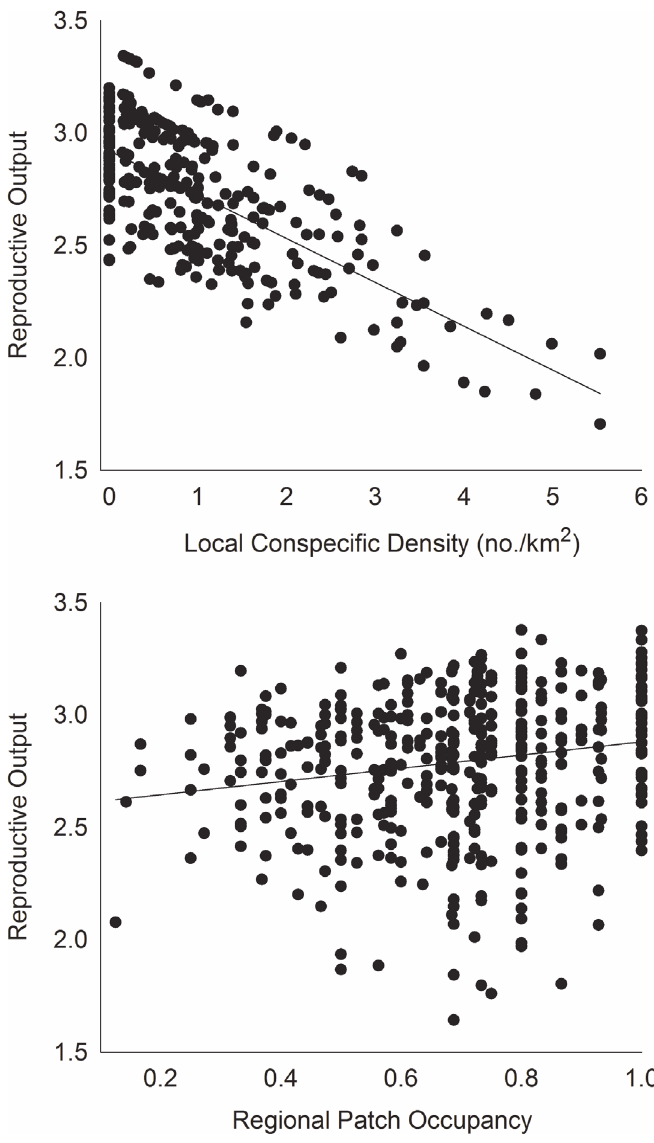
Fig 6. Effects of conspecifics on reproductive output of ferruginous pygmy-owls in northwest Mexico, 2001 – 2010. Conspecific density was measured around each focal patch each year and regional occupancy was measured as the proportion of patches occupied in each of 11 watershed regions in each year. Estimates of the effect of local conspecific density are based on model {Density} and estimates of the effect of regional occupancy are adjusted for the effects of local density from model {Density + Occ region } in S4 Appendix.